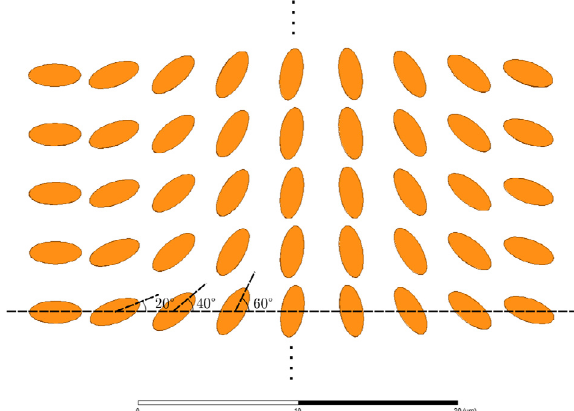
Figure 3. Top view of the refraction transmitarray. Unit cells from left to right have an incremental rotation angle of 20 (cid:2)